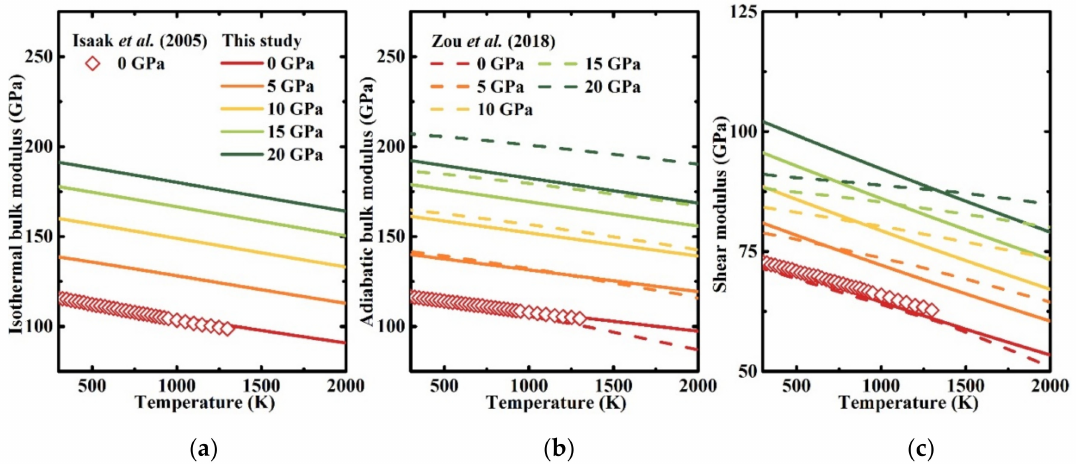
Figure 3. Elastic moduli of diopside as a function of temperature at various pressures. Solid lines refer to our calculated results and dashed lines refer to the first-principle calculation results from Zou et al. (2018) [24]. The diamonds correspond to the results from Isaak et al. (2006) [33]. ( a ) Isothermal bulk modulus ( b ) Adiabatic bulk modulus ( c ) Shear modulus.